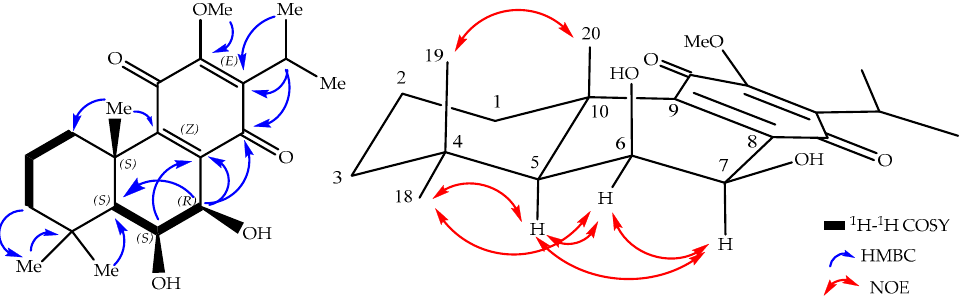
Figure 2. Key 1 H– 1 H COSY (bold lines), HMBC (blue arrows) and NOE (red arrows) correlations of 1 .